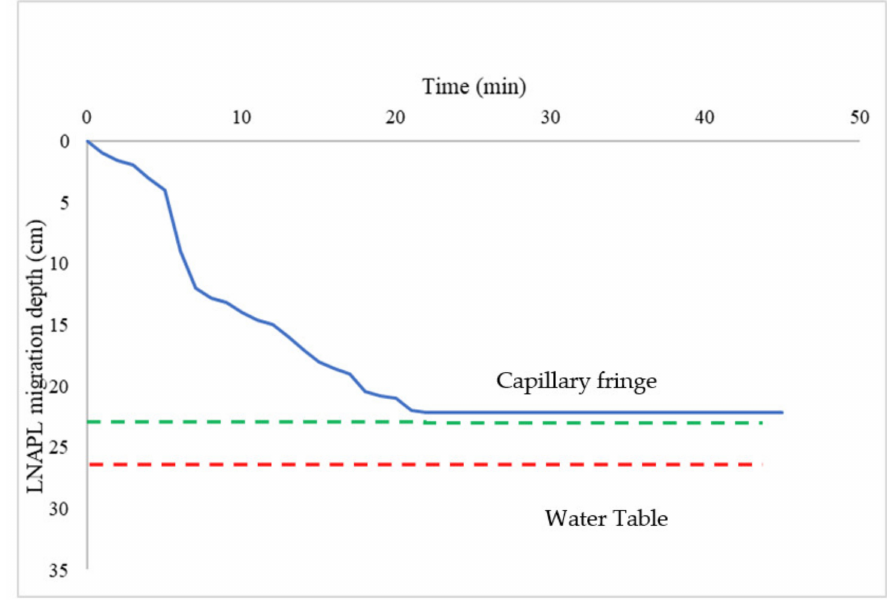
Figure 3. The behavior of 100 mL diesel volume in capillary fringe and water table.